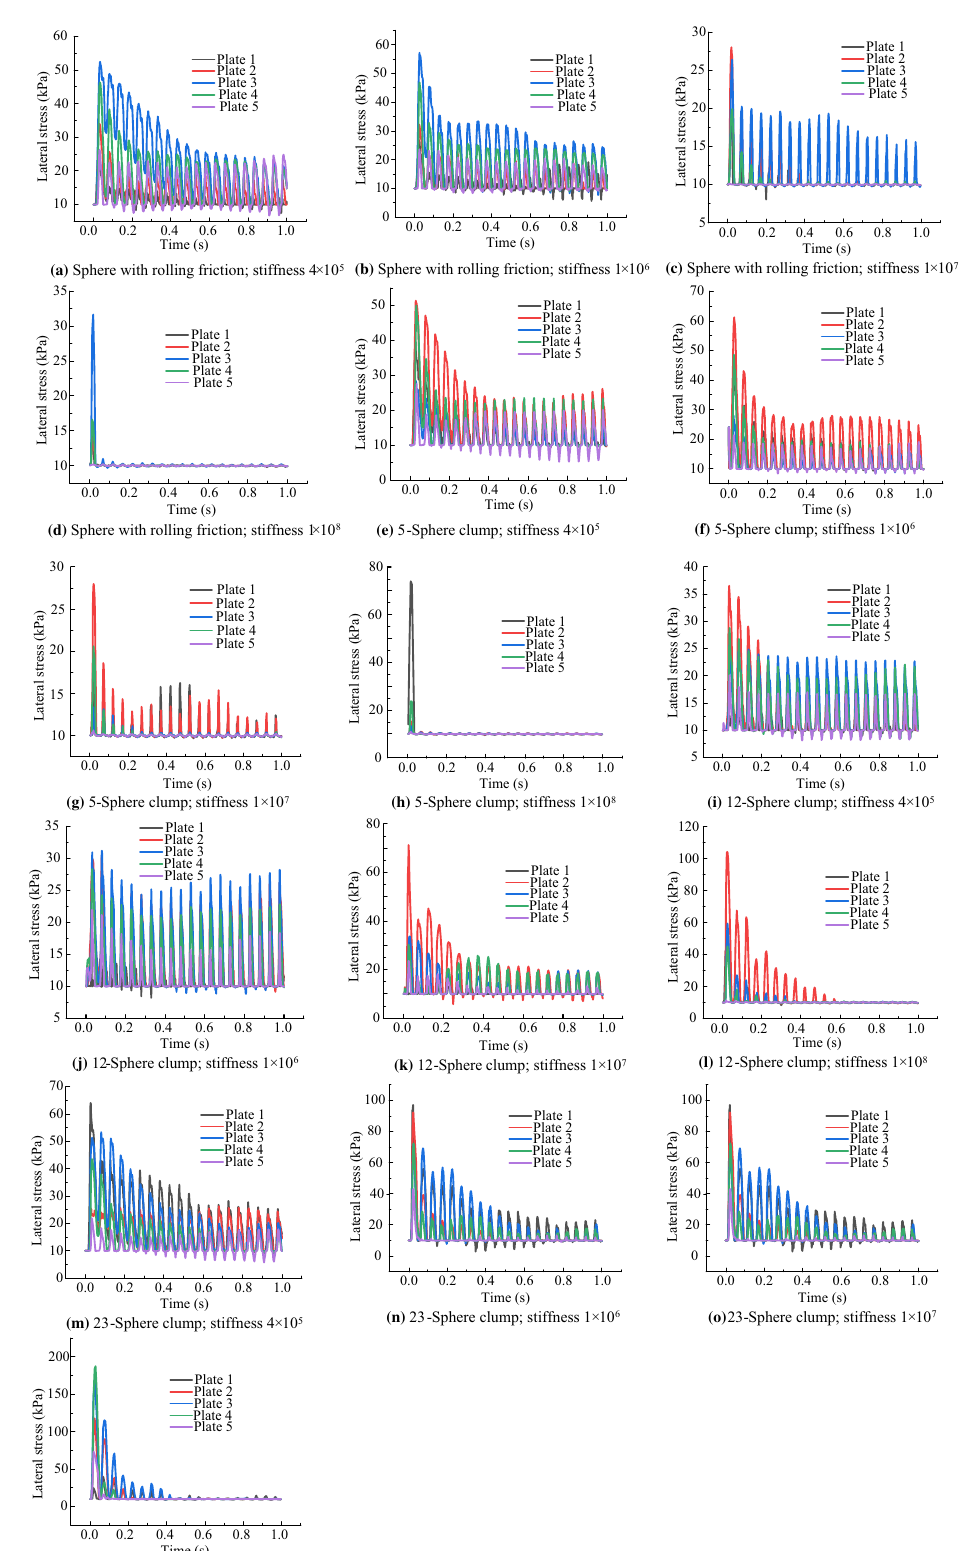
Fig. 13 Lateral stress vs time of the five movable